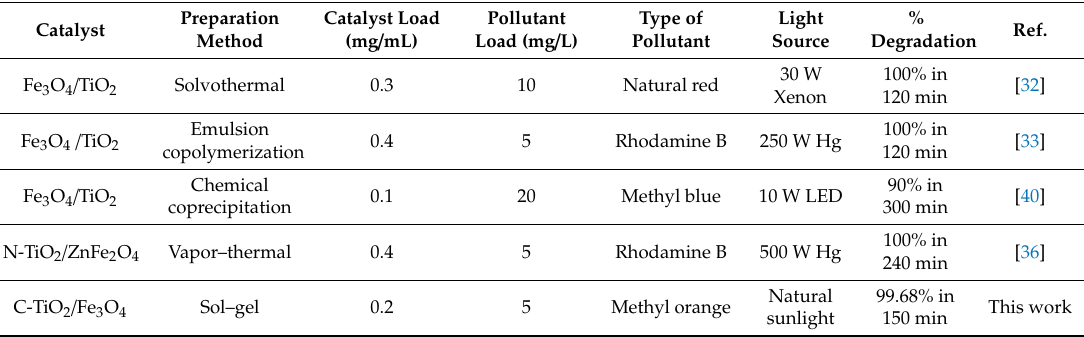
Table 1. Comparison of photocatalytic activities of some selected nanocomposites with the present work.